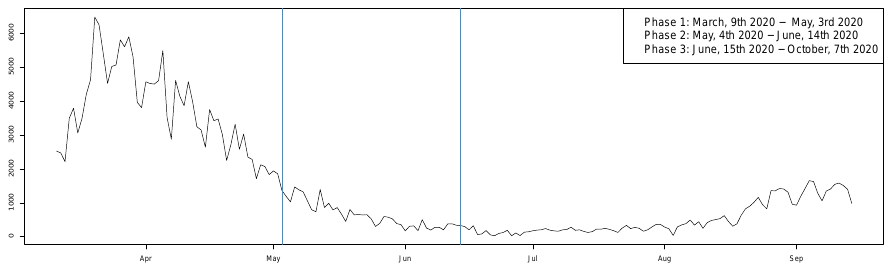
Figure 3. Daily new cases in Italy during the first wave of infections. The vertical blue straight lines individuate the three phases.